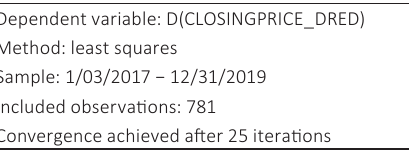
Table 9. Result of the selected model for Dr. Reddy’s